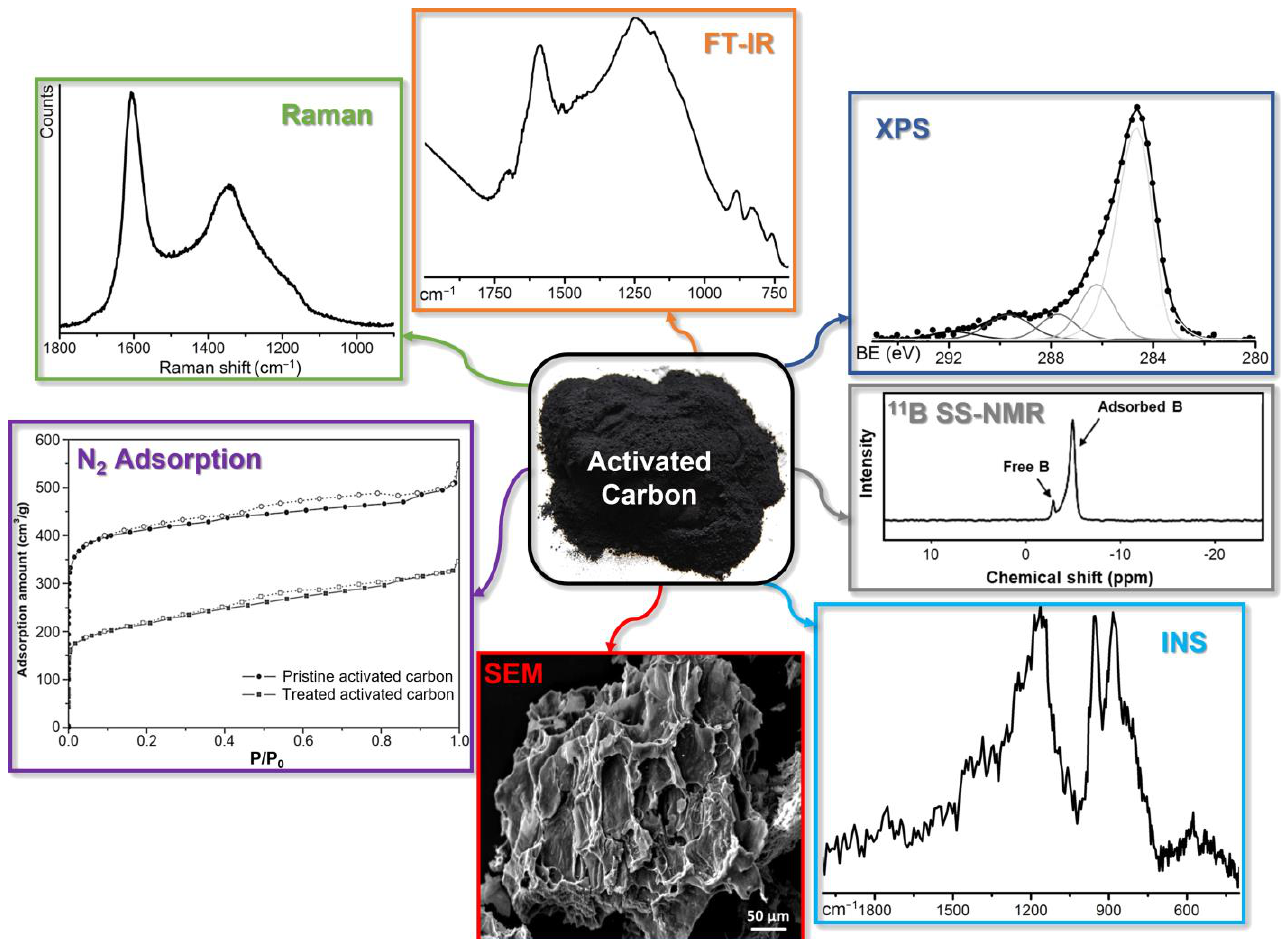
Figure 7. Overview of the principal characterization techniques mostly employed for boronated carbonaceous materials.